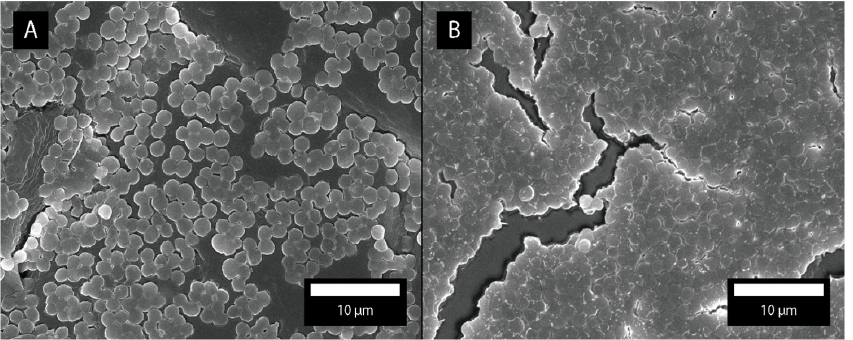
Figure 7. SEM micrographs of natural ( A ) and artificial leather ( B ). The difference in the surface morphology dictates the bacterial adhesion.